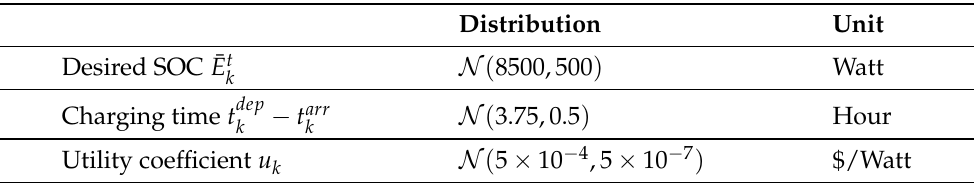
Table 1. Distributions of the EV